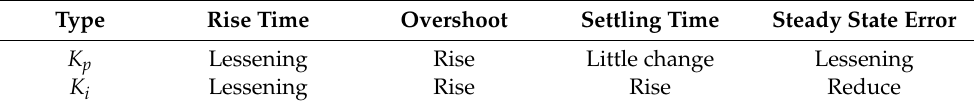
Figure 6. Structure of proportional integral (PI) control. Table 1. Attributes of proportional integral (PI) regulator